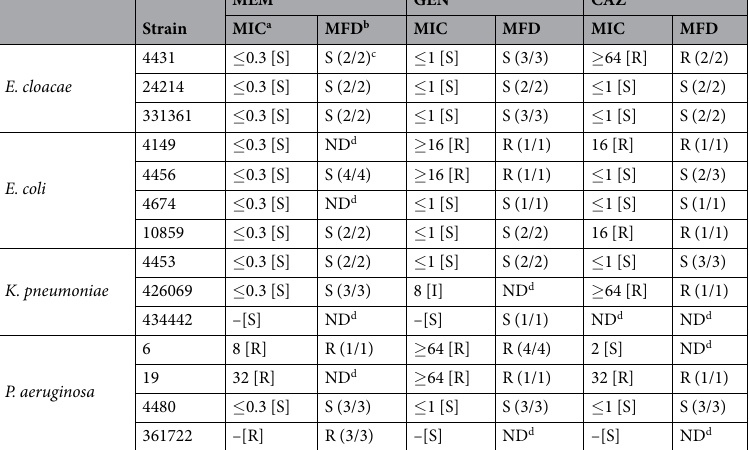
Table 1. Comparison of standard susceptibilities and microfluidic designations obtained using our stress- based AST method. MIC values are given in µ g/mL. a Minimum Inhibitory Concentrations reported in µ g/mL.